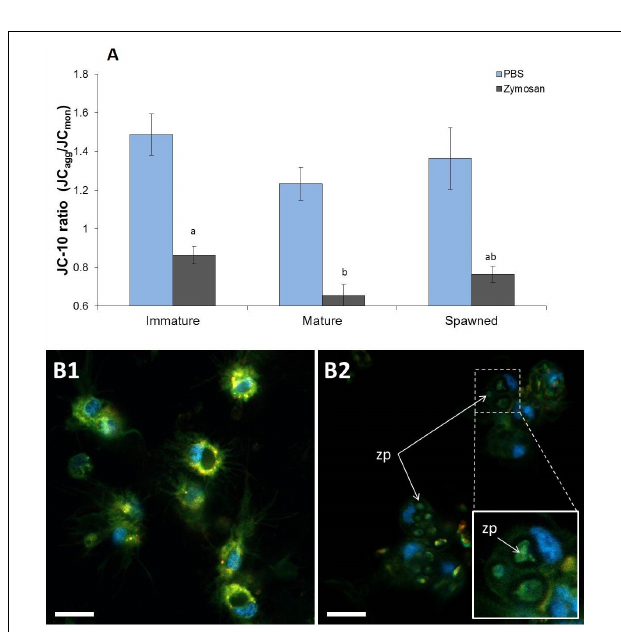
FIGURE 3 | Mitochondrial membrane potential from A. purpuratus hemocyte obtained through JC-10 staining (red and green fluorescence). (A) Values associated with the same letter belong to the same subset based on a posteriori multiple comparison test Student-Newman-Keuls. Challenge with zymosan caused in all cases a decrease in JC-10 ratios. (B) Subpanels 1 and 2 show representative images of hemocytes respectively without and with zymosan challenge. Blue fluorescence corresponds to Hoechst 33342 staining (nuclei-specific). Scale bars = 10 µ m. Zp = phagocyted zymosan particles ( n = 4–8 per condition and treatment).